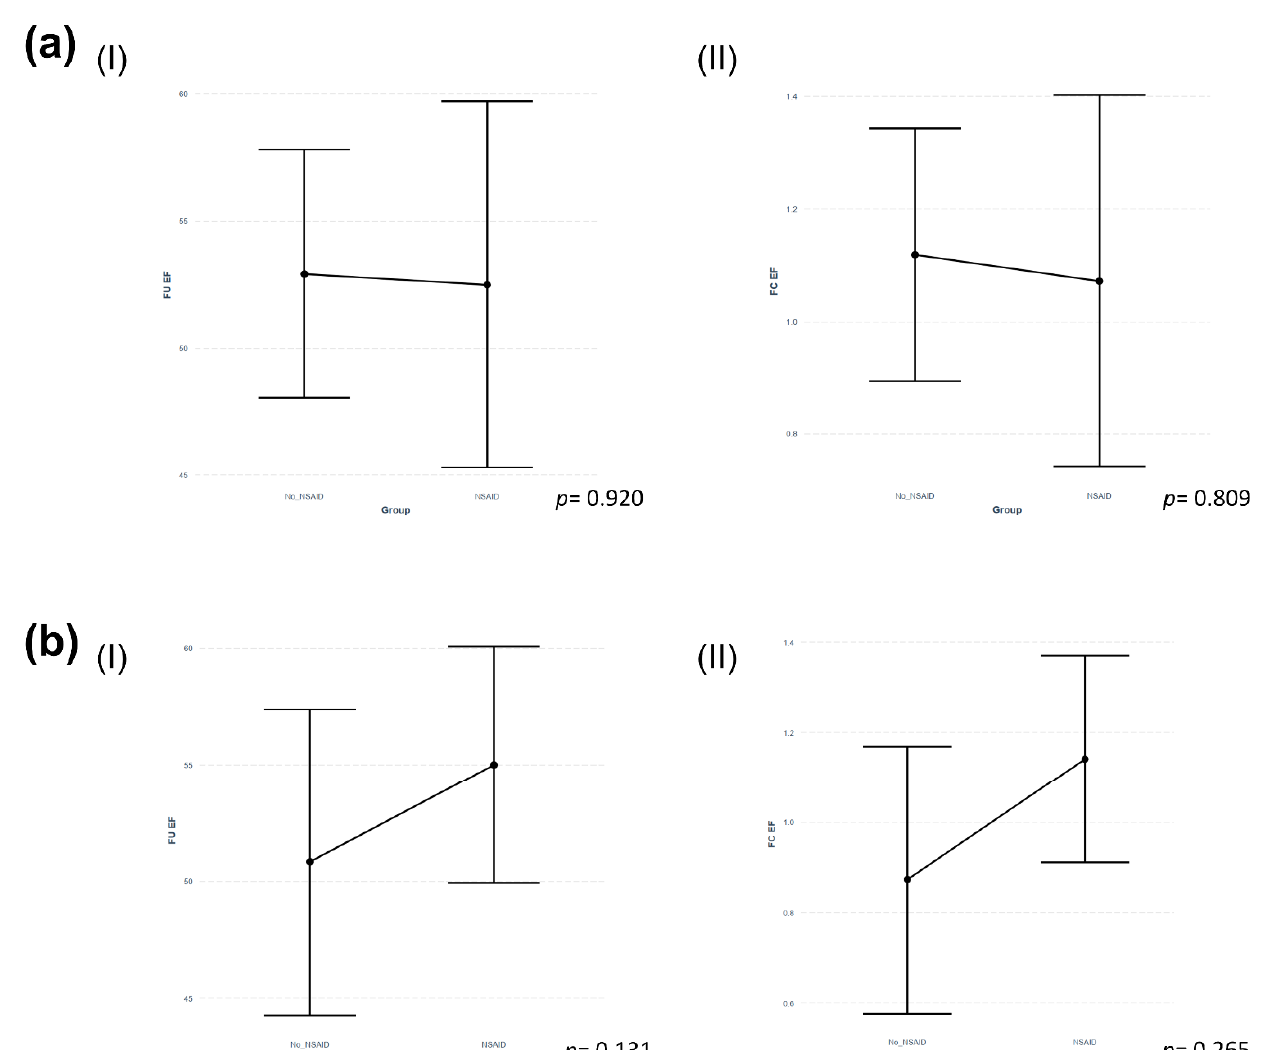
Figure 2. Left ventricular systolic function at baseline and at follow-up 90 to 180 days after hospi- talization in ( a ) patients who did not receive NSAIDs and ( b ) patients treated with NSAIDs. De- picted is the p -value for the Wilcoxon signed-rank test for paired samples. Abbreviations: EF = ejec- tion fraction, NSAID = non-steroidal anti-inflammatory drug.